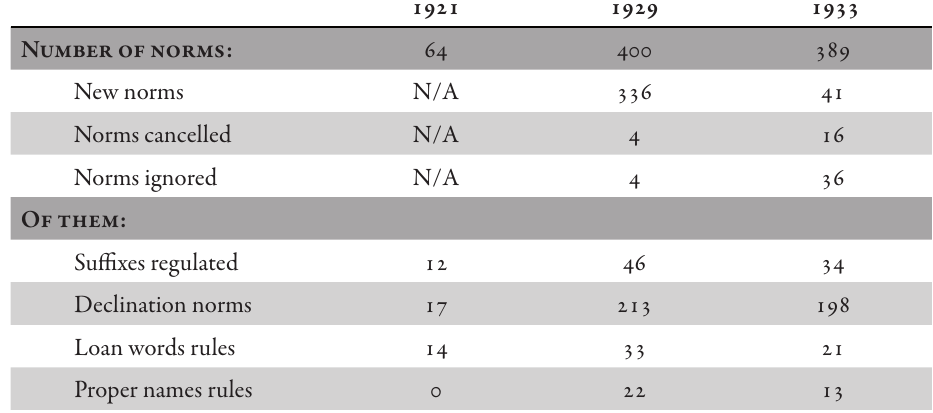
Quantitative comparison of the three major Ukrainian orthographies in the 1920s and